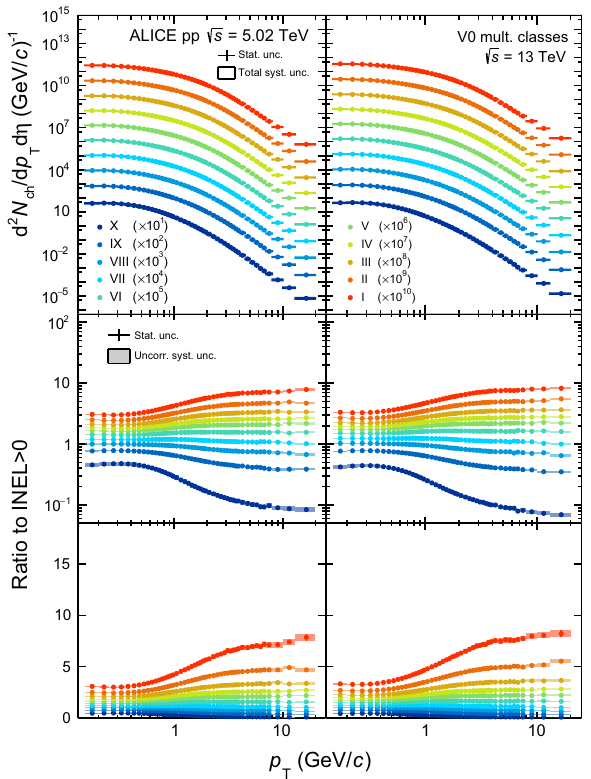
Fig. 3 Transversemomentumdistributionsofchargedparticlesfordif- ferent V0M multiplicity classes. Results for pp collisions at and 13TeV are shown in the left and right panels, respectively. Sta- tistical and total systematic uncertainties are shown as error bars and boxes around the data points, respectively. In the middle panels, ratios of multiplicity dependent spectra to INEL > 0 are shown in logarithmic scale. The systematic uncertainties on the ratios are obtained by consid- ering only contributions uncorrelated across multiplicity. The spectra are scaled to improve the visibility